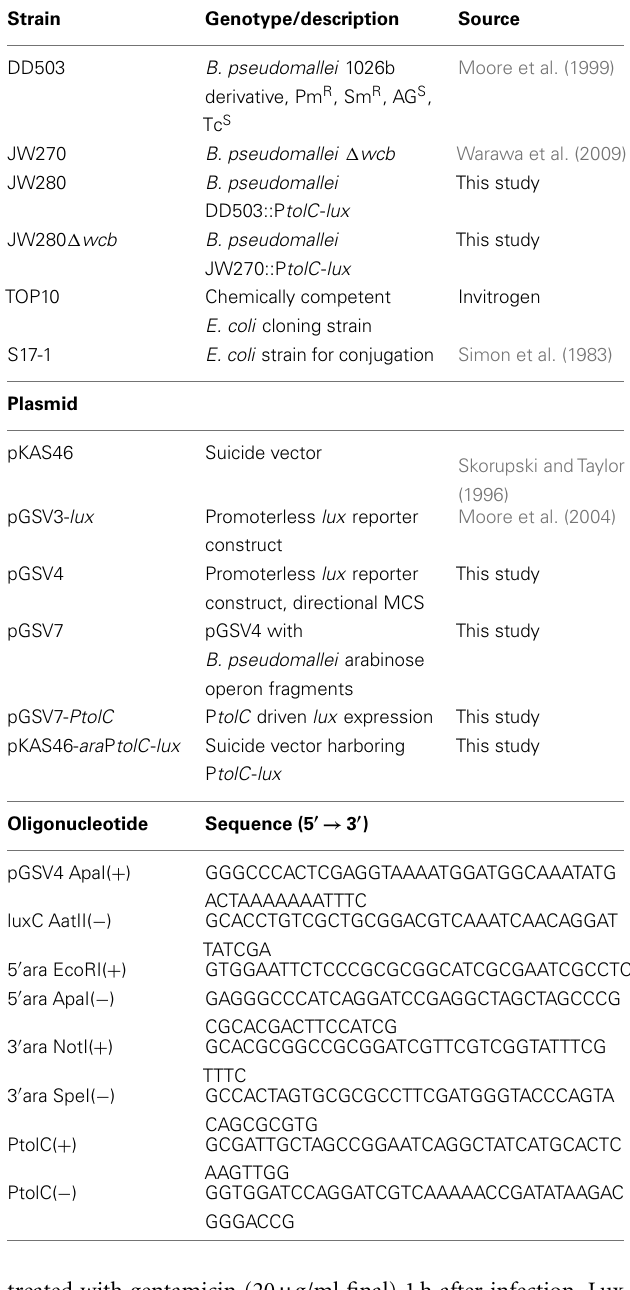
Table 1 | Bacterial strains, plasmids and